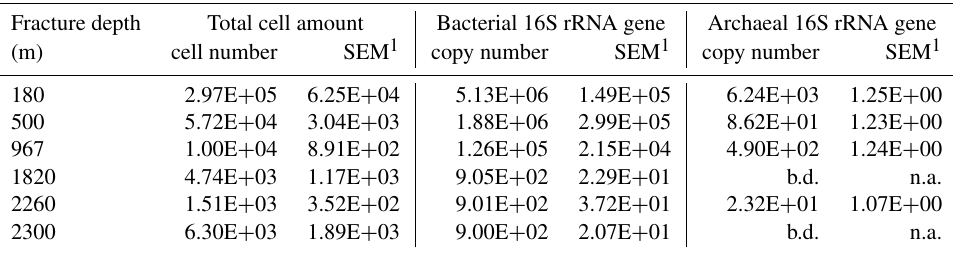
Table 2. The total number of cells and the 16S rRNA gene copy numbers of microbial communities in six fractures of Outokumpu. Values are given in mL − 1 .